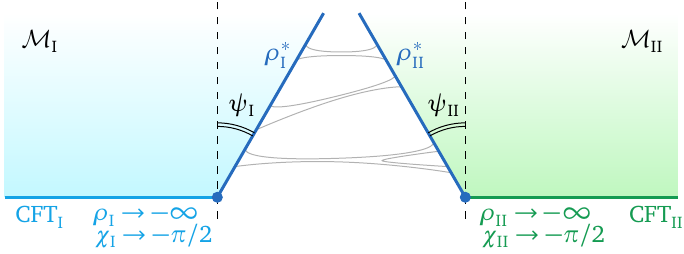
and ψ as the geometric angles be- I II